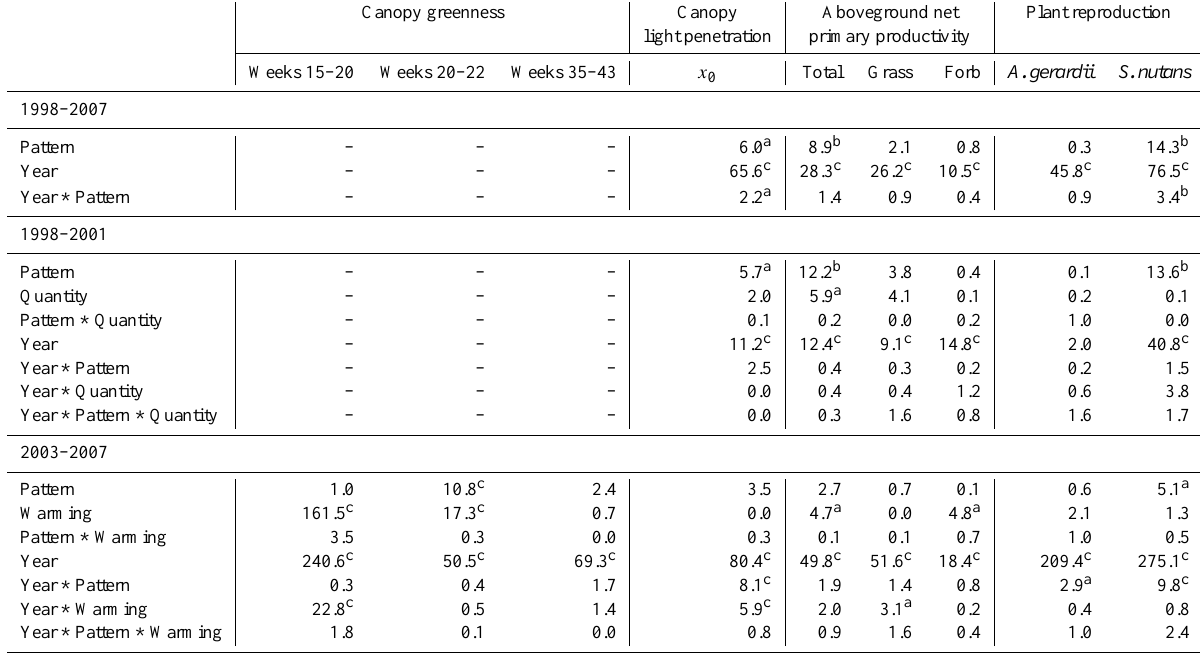
Table A2. Analysis of variance F statistics for vegetation responses to pattern, quantity, and warming treatments in